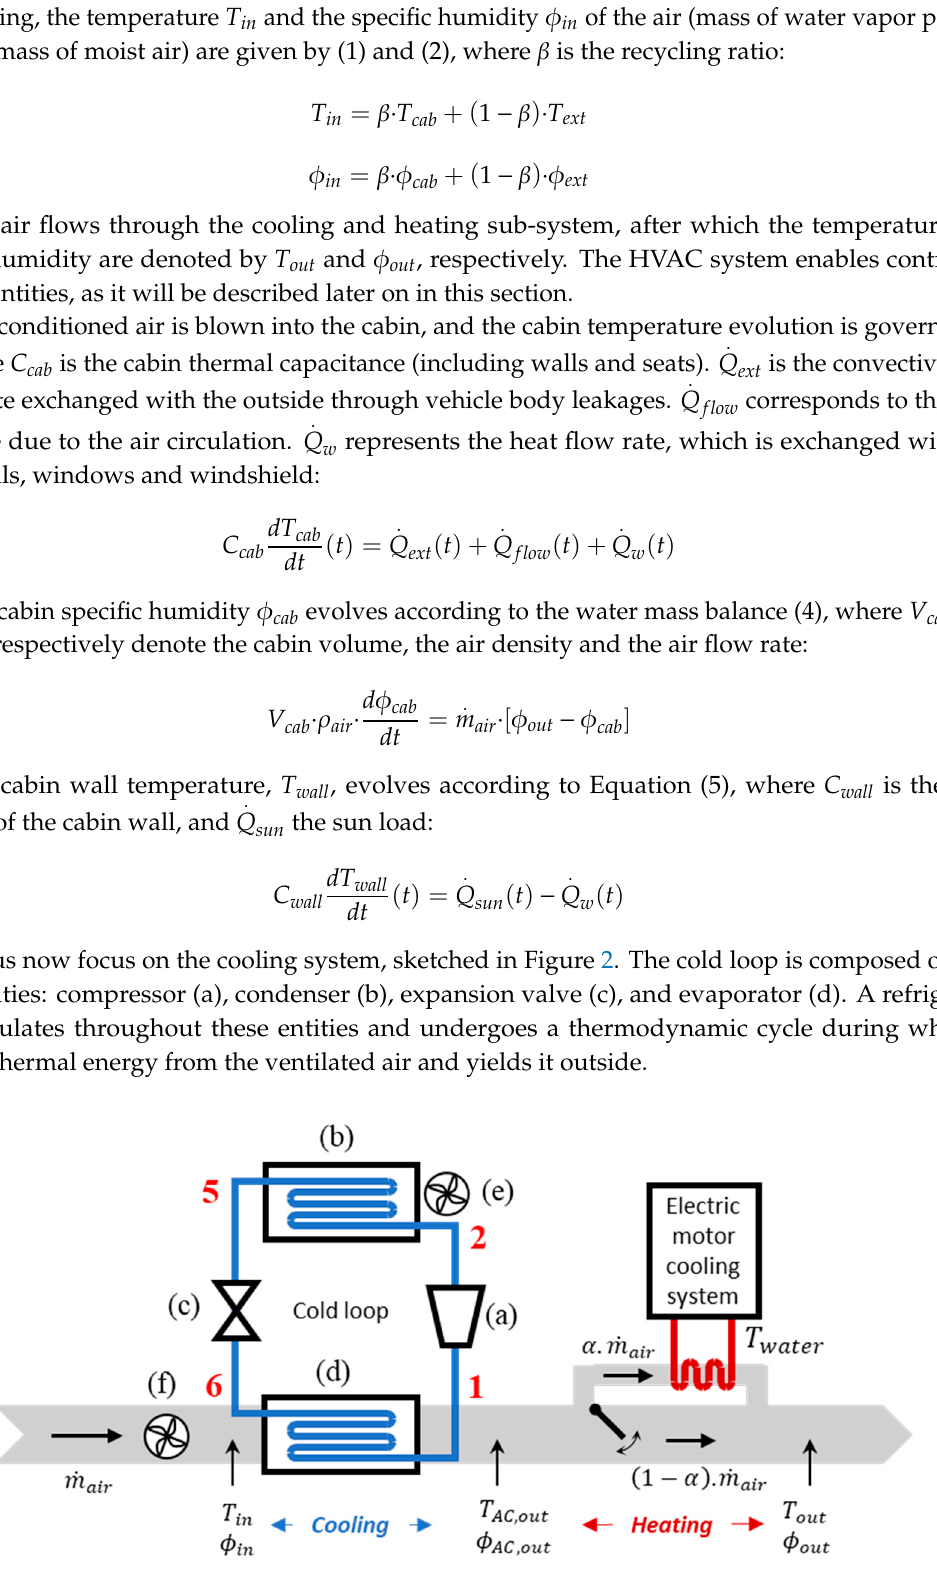
Figure 2. Schematic diagram of the air cooling and heating system: ( a ) compressor—( b ) condenser—( c ) expansion valve—( d ) evaporator—( e ) moto-ventilator group (MVG)—( f ) ventilation fan. The points 1, 2, 5 & 6 correspond to different thermodynamic states of the refrigerant explained in Figure 3.